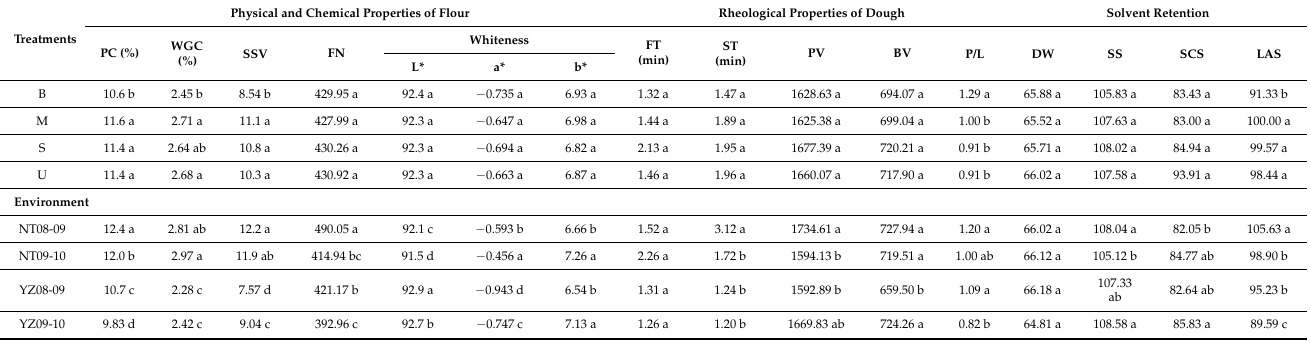
Table 1. Physical and chemical properties of flour, rheological properties of dough, and solvent retention of wheat under different fertilizer treatments and in different growth